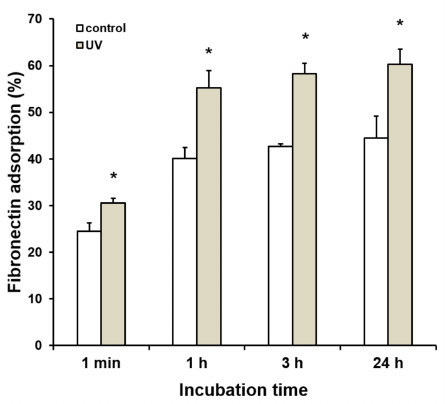
Figure 2. Enhanced protein adsorption on titanium surfaces using UV treatment. Data represent means ± standard deviation of adsorption rates of bovine plasma fibronectin (FN) after 1 min and 1, 3, and 24 h of incubation for control- and UV-treated titanium disks ( n = 3). Asterisks indicate significant di ff erences (* p < 0.05, Welch’s t